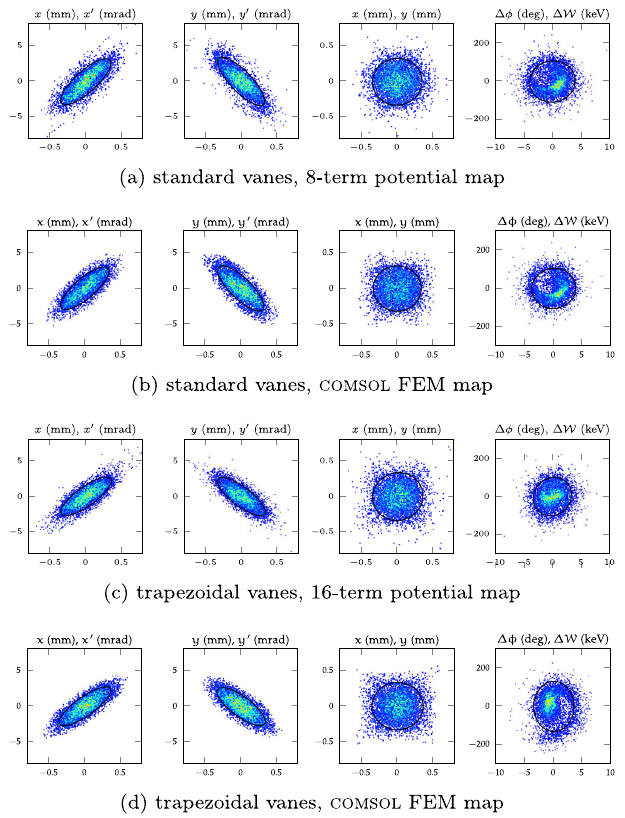
FIG. 14. Comparison of the output phase spaces of the standard (a), (b) and trapezoidal vane design (c), (d), each shown for the potential function and FEM